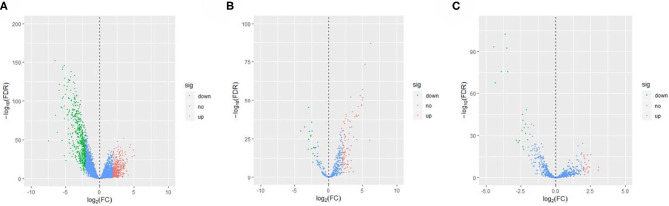
Volcano diagram of the differential expression RNAs in ECs and controls. (A) Volcano diagram of mRNA, (B) volcano diagram of miRNA, and (C) volcano diagram of lncRNA.